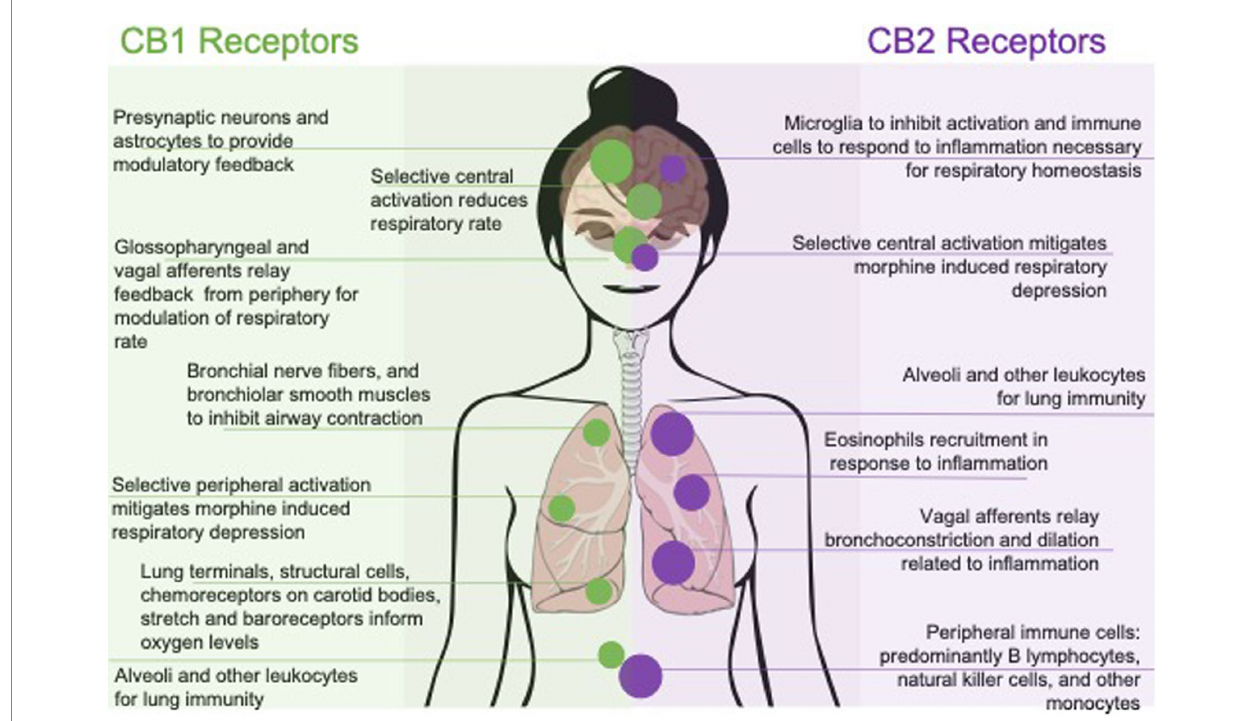
FIGURE 1 Effects of pharmacologically targeting central or peripheral CB1 and CB2 receptors on respiratory function. Respiratory outcomes are represented by their mechanism of action; with CB1 selective affinity to the left and CB2 selective affinity to the right. Outcomes are also represented with peripherally mediated outcomes along the bottom and centrally, or systemic outcomes, along the